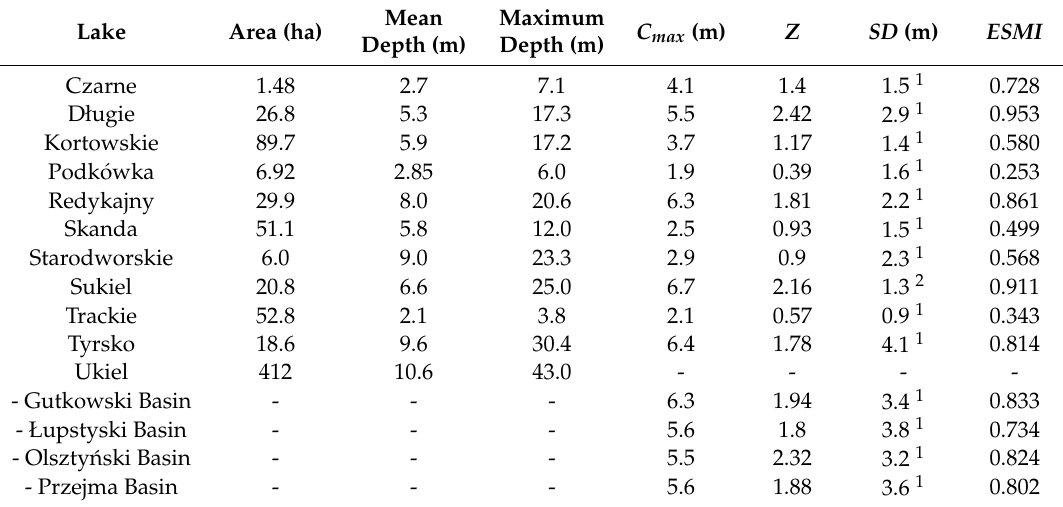
Morphometric information, aquatic vegetation parameters ( Z —colonization index, C max —maximum vegetation depth; SD —Secchi disc) and the values of the Ecological Status Macrophyte